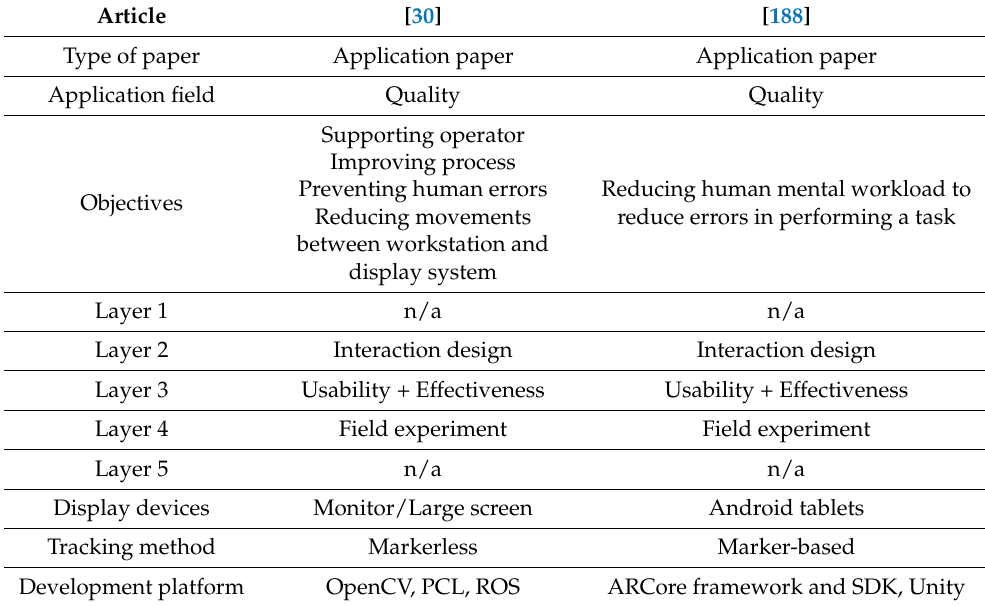
Table 6. Example of data extraction from selected papers for the